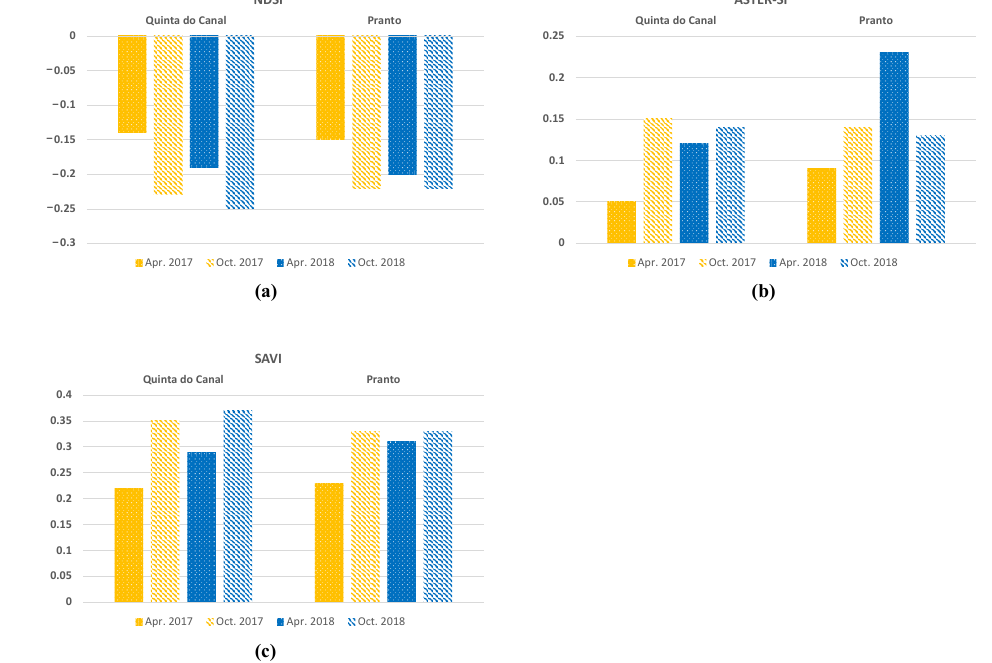
Figure 7. Appraisal of soil salinity in Quinta do Canal and Pranto using ( a ) NDSI, ( b ) ASTER_SI and ( c ) SAVI, before and after the rice crop cultivation season 2017 and 2018. Table 6. NDSI, ASTER_SI and SAVI for the selected rice field plots of Quinta do Canal and Pranto: mean and coefficient of variation (CV) for specific dates in Spring and Autumn that illustrate the salinity conditions before and after the rice cultivation period in 2017 and 2018.